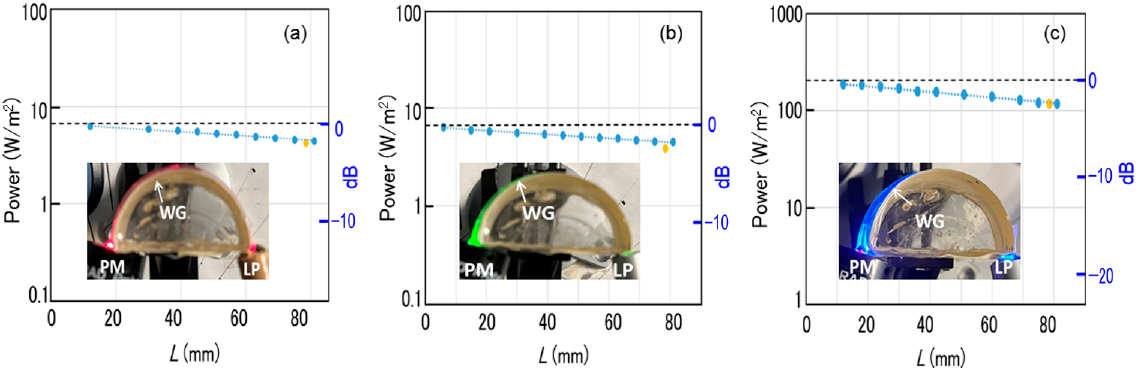
Figure 3. Blue solid circles and orange solid circles plot the powers of the light guided along the planar WG and cylindrical WG, respectively, in edge light injection configurations for ( a ) red, ( b ) green, and ( c ) blue lasers. The right ordinates show the ratio of the power at L to that at L = 0 in dB, indicating the power loss. The insets are pictures of the experiment. For red, α = 5/m; for green, α = 5/m; for blue, α = 6/m. The blue and orange circles are almost on the same lines, indicating that there is no extra loss caused by the cylindrical geometry when compared to the planar waveguides.